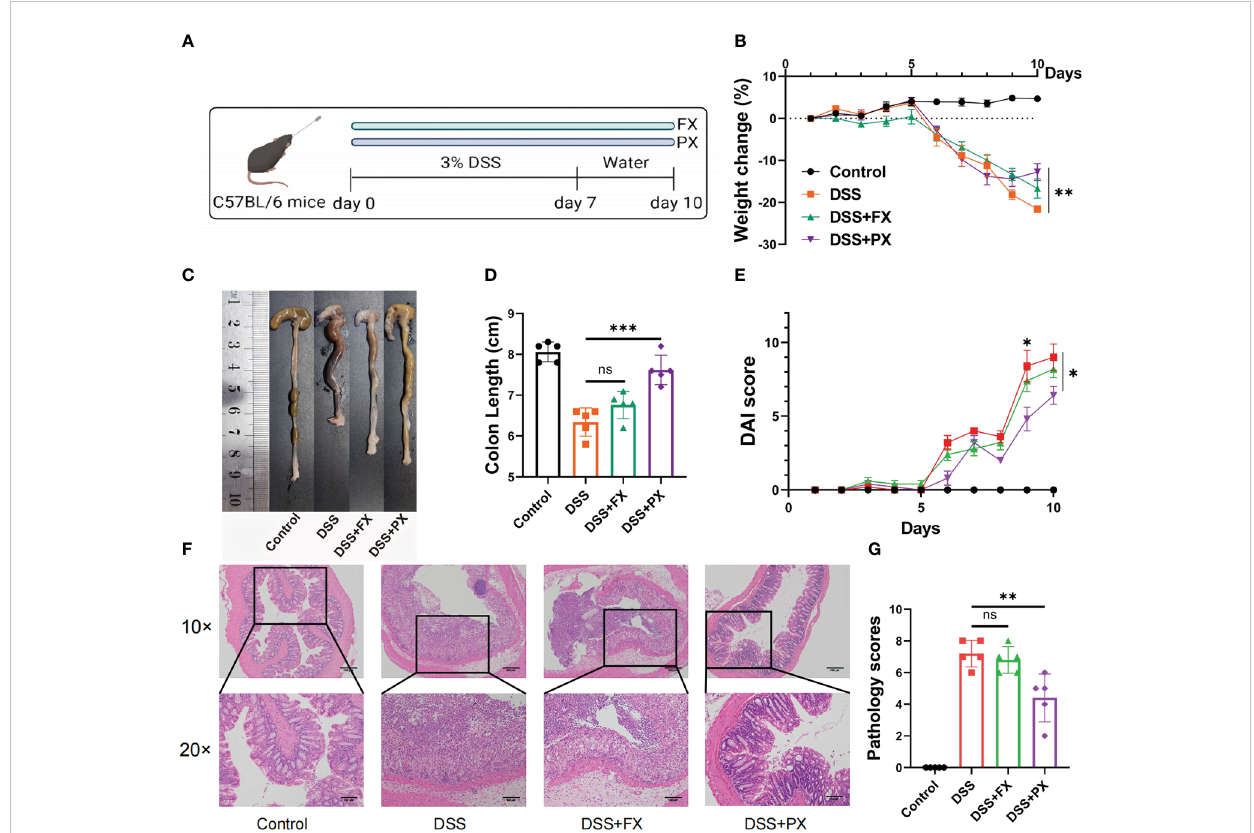
FIGURE 1 Antidepressants can resolve intestinal in fl ammation in a preclinical model of (D) cluster2 patients. (A) Induction of experimental ulcerative colitis. Mice received 3% (wt/vol) DSS dissolved in drinking water for 7 days followed by normal drinking water for 3 days. (B) Body weight change. (C, D) Representative pictures of colon gross appearance and colon length. (E) DAI score. (F, G) Representative microscopic pictures of H&E staining (40× and 100× magni fi cation) and histology scores. Data are pooled from each independent experiment with n=5 mice per group; The asterisks represented the statistical P-value (ns P > 0.05; *P < 0.05; **P < 0.01; ***P <